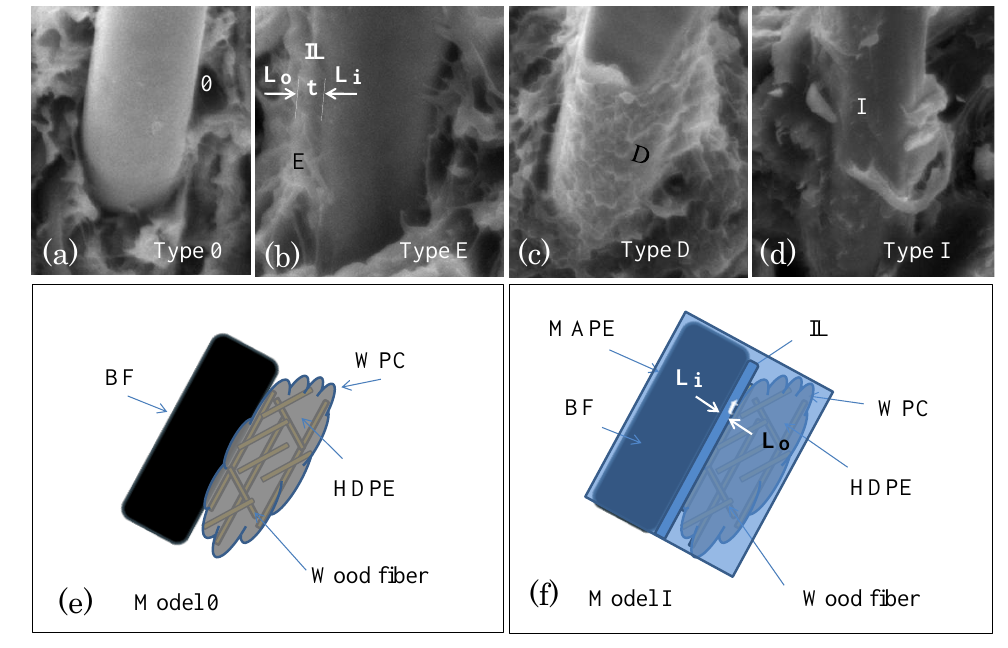
and L : the inner and i o